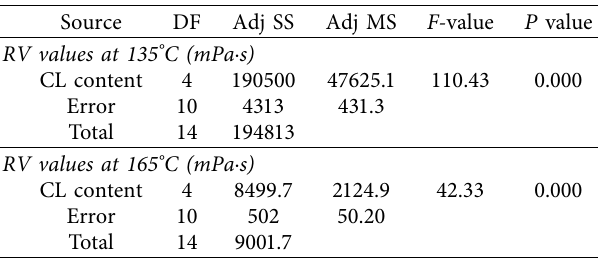
Table 5: One-way ANOVA: rotational viscosity values versus CL